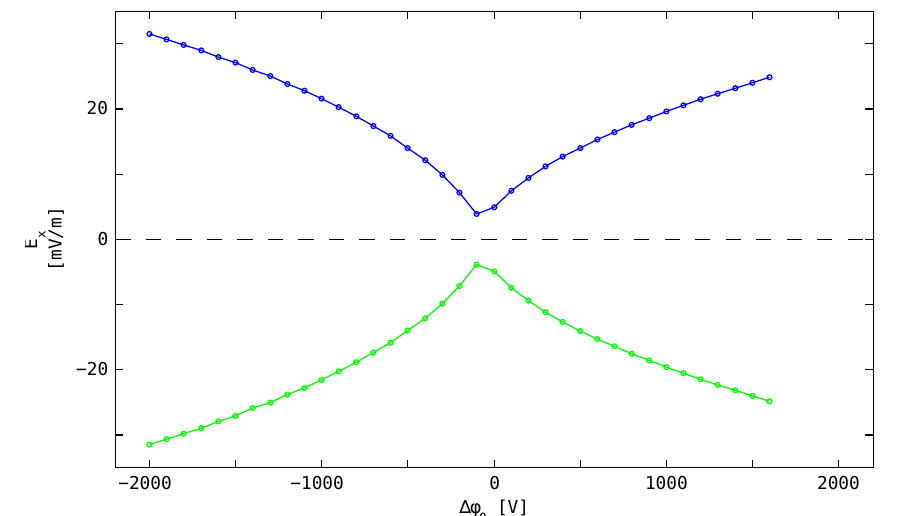
Fig. 11. Minimum (green) and maximum (blue) electric field strength in a 2000km-wide e − -H + slab, for various values of 1φ 0 = φ( ±∞ ) , in a configuration where V 0 y = 0kms − 1 . No equilibrium is found for 1φ 0 < − 2050V or > +